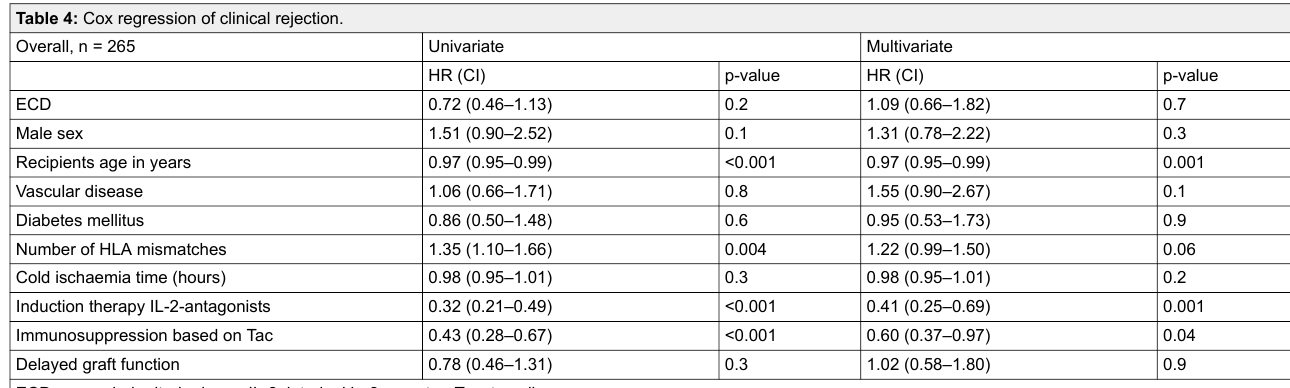
Table 4: Cox regression of clinical